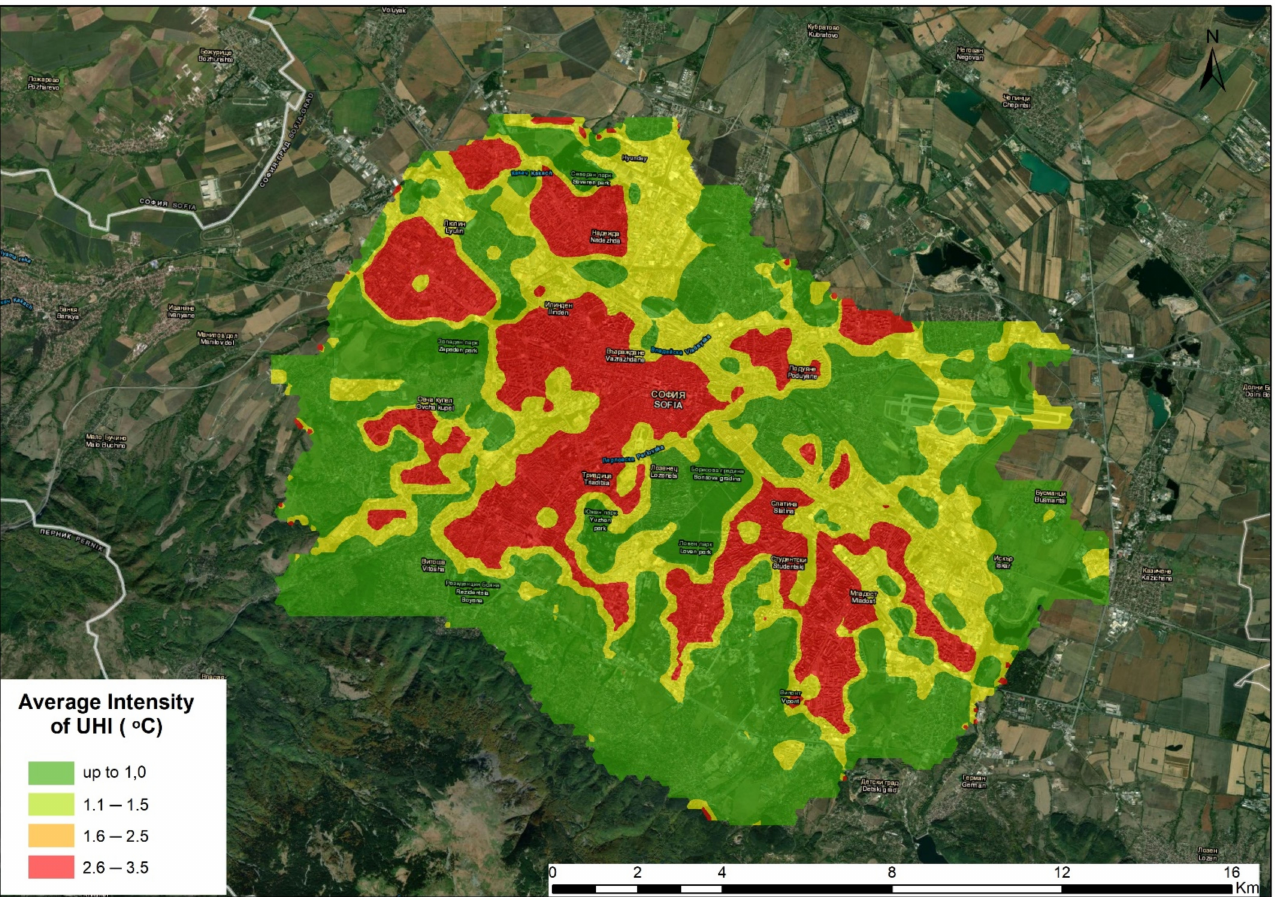
Figure 8. Map of the average magnitude of intensity of SUHI in Sofia for August 2019 (8:00 p.m.–10:00